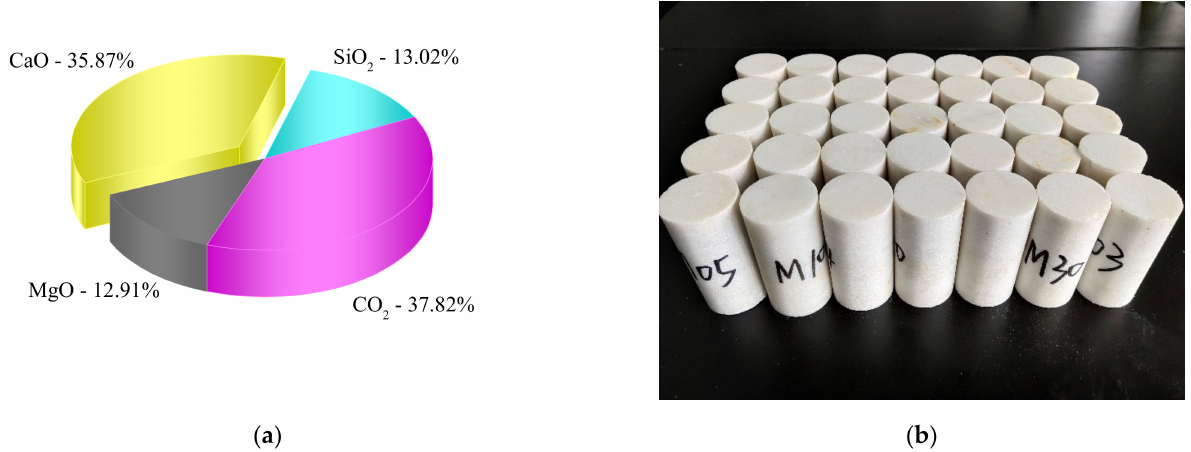
Figure 1. ( a ) XRF result of tested marble; ( b ) Images of tested marble